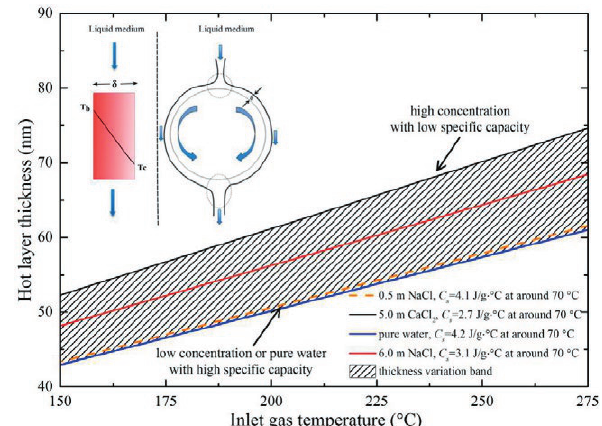
Figure 5. Relationship between the temperature of the inlet gas and the estimated thickness of the transient hot bubble surface layer around a 1 mm radius bubble in pure water, 0.5 m NaCl and 5.0 m CaCl 2 . Reprinted by permission of the publisher (Taylor &Francis Ltd, http://www.tandfonline.com) from Ref. 10.